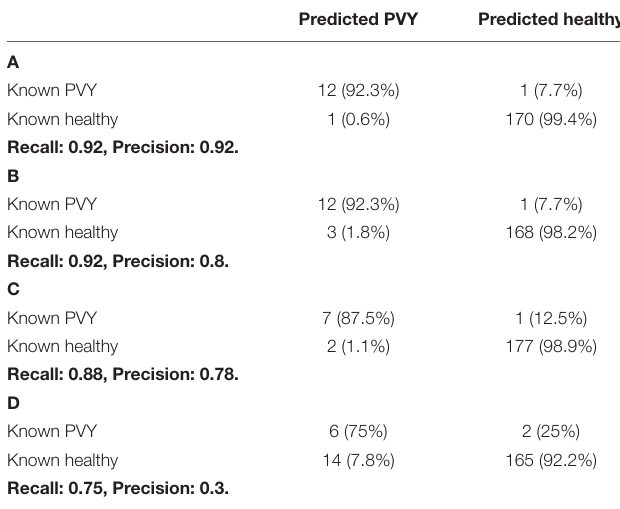
TABLE 4 | Confusion matrices of row 6 (A,B) and 7 (C,D) , measured on TABLE 3 | Confusion matrices of row 6 (A,B) and 7 (C,D) , measured on 2017/06/27 (A,C) and 2017/07/03 (B,D) , after correction for neighboring 2017/06/27 (A,C) and 2017/07/03 (B,D) . Predicted PVY Predicted healthy